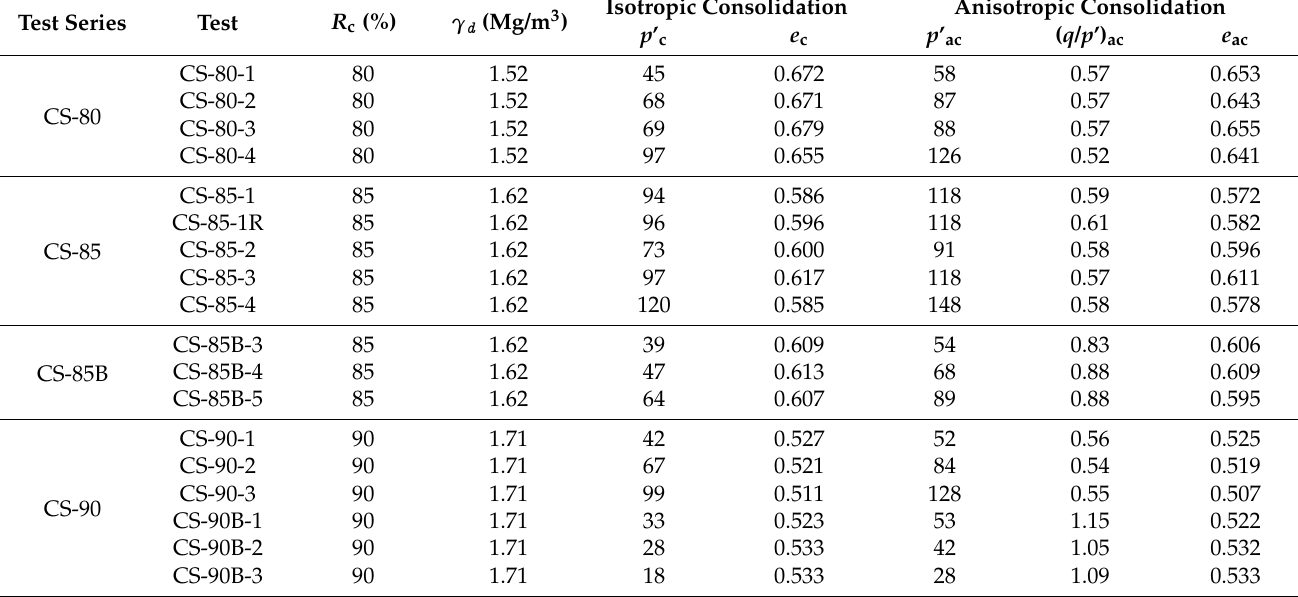
Table 3. Constant shear (CS) test